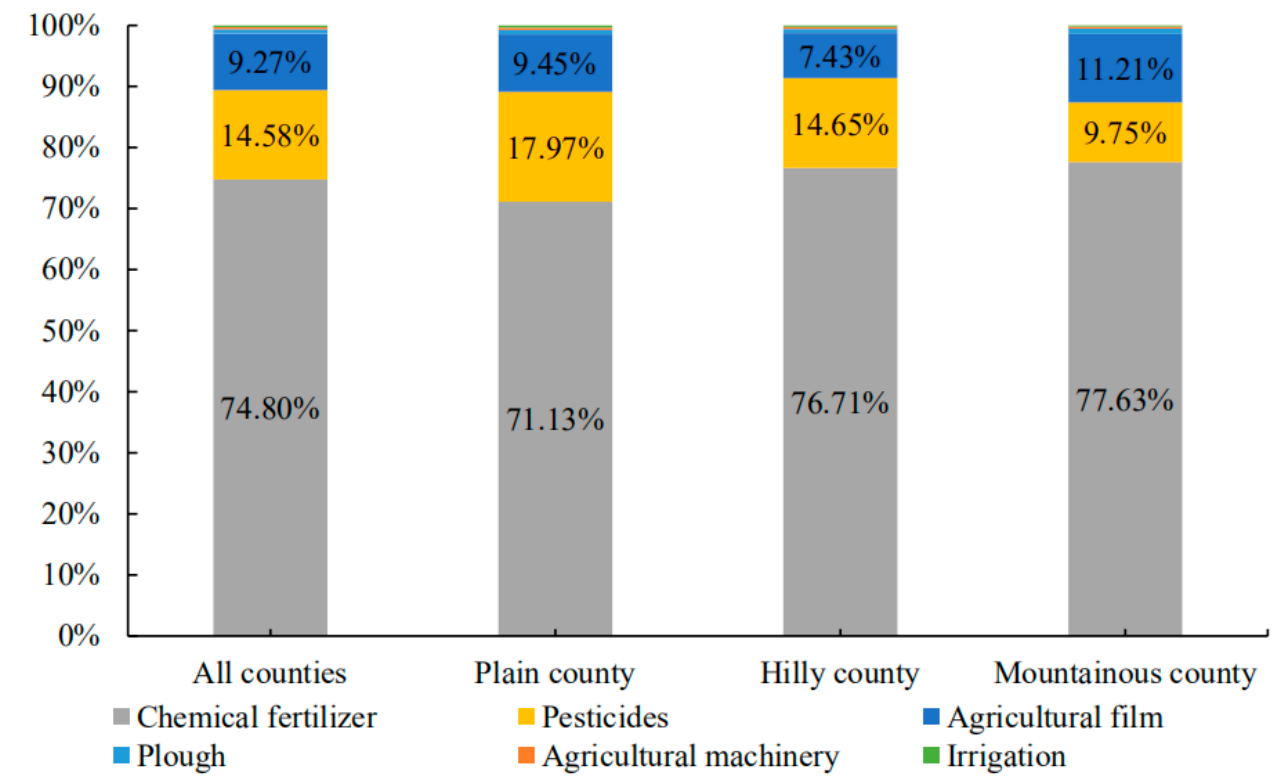
Figure 5. Topographic differences of different carbon emission sources.